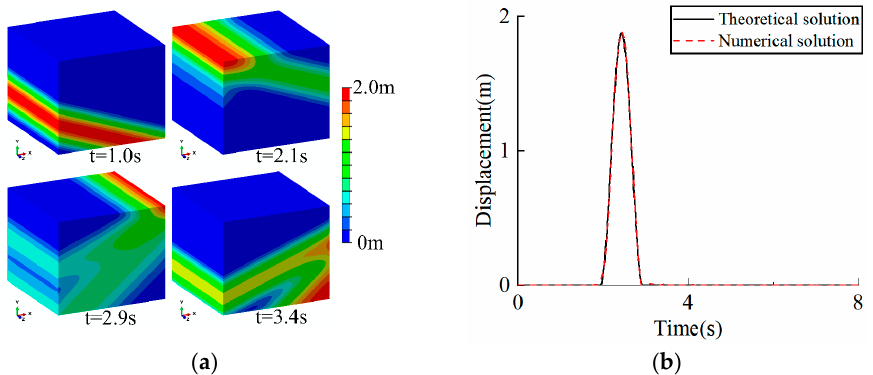
Figure 3. Wave propagation in the 3D finite element model and the displacement time history at point A under an incident angle of 20°; ( a ) displacement cloud diagram at different times, and ( b ) displacement time history curves at point